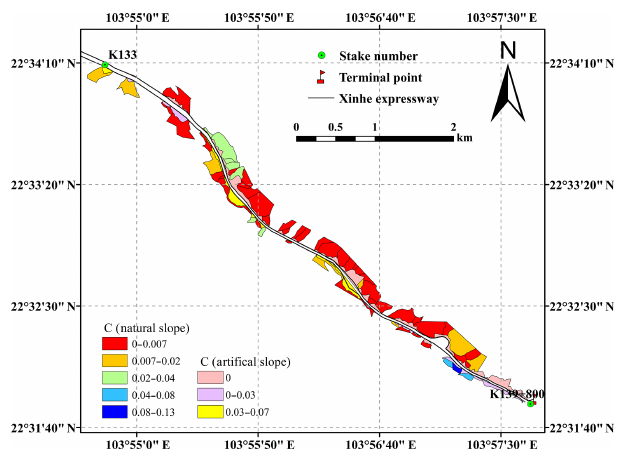
Figure 9. Spatial distribution map of the cover and management practice factor.